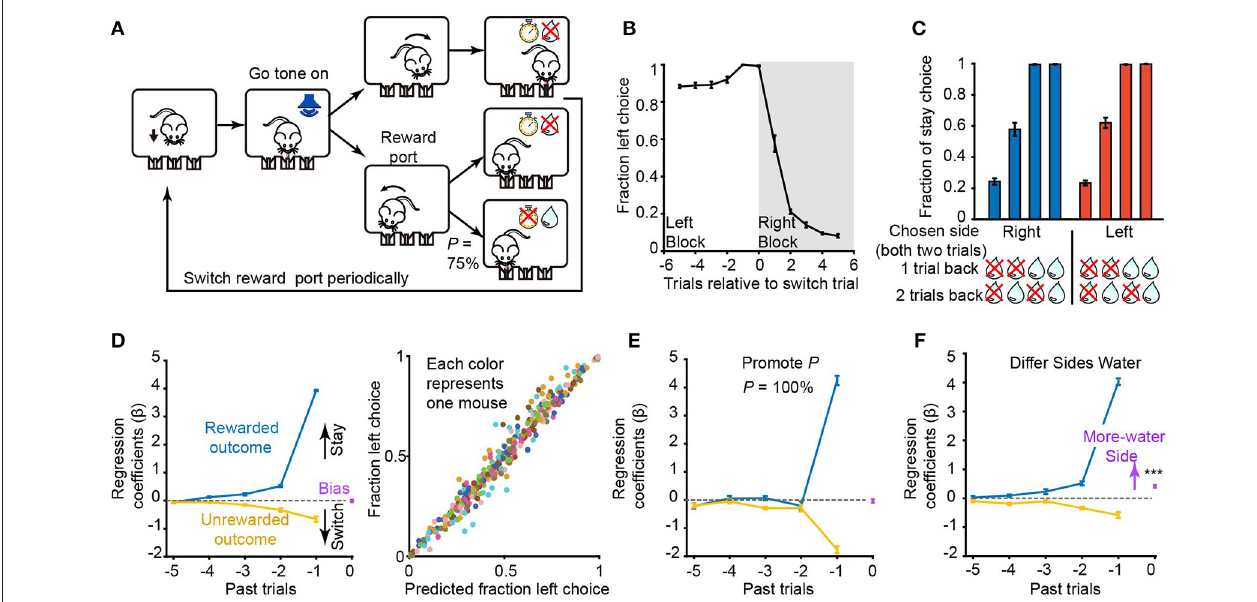
FIGURE 6 | ArControl verification through the probabilistic switching task. (A) Sequence of events in a probabilistic switching task. (B) Fraction of choices for the left port ( n = 8 mice) for trials before and after a switch of the rewarded port (at trial 0). (C) Fraction of stay choices for reward histories in which two consecutive choices were made to one port. (D) Left subplot: contribution of intrinsic bias (purple), rewarded (blue), and unrewarded (yellow) outcomes in the previous five trials on choices in current trial derived from the logistic regression. Right subplot: the actual fraction of choices for the left port plotted against the predicted fraction by the regression model ( n = 8 mice, 43,000 trials totally). Data from each subject are grouped into 50 bins and represented by different colors. (E) Similar to (D) , but promotes the probability to 100 % ( n = 8 mice, 16,000 trials totally). (F) Differ the reward size between ports ( n = 4 mice, more water at left; n = 4 mice, at right; 30,000 trials totally). Data are mean ± s.e.m. Bias = 0.41 ± 0.04 mean ± s.e.m, Student’s t -test, *** p < 0.001.